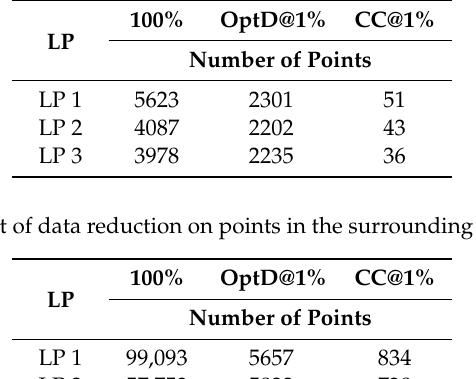
Table 3. E ff ect of data reduction on points appertaining to a LP. Table 3. Effect of data reduction on points appertaining to a LP.